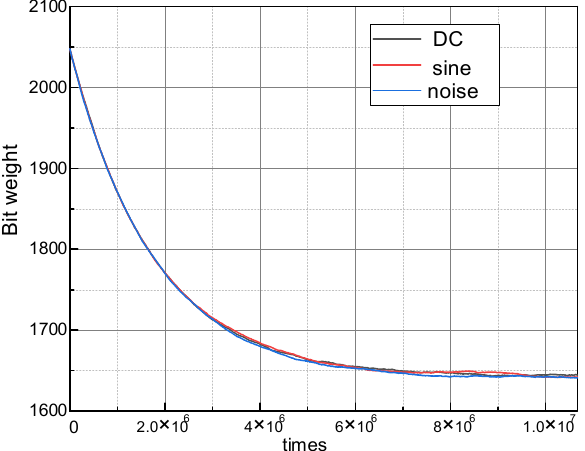
Figure 5. ADC dynamic performance learning curves: ( a ) without signal elimination; ( b ) with signal elimination.